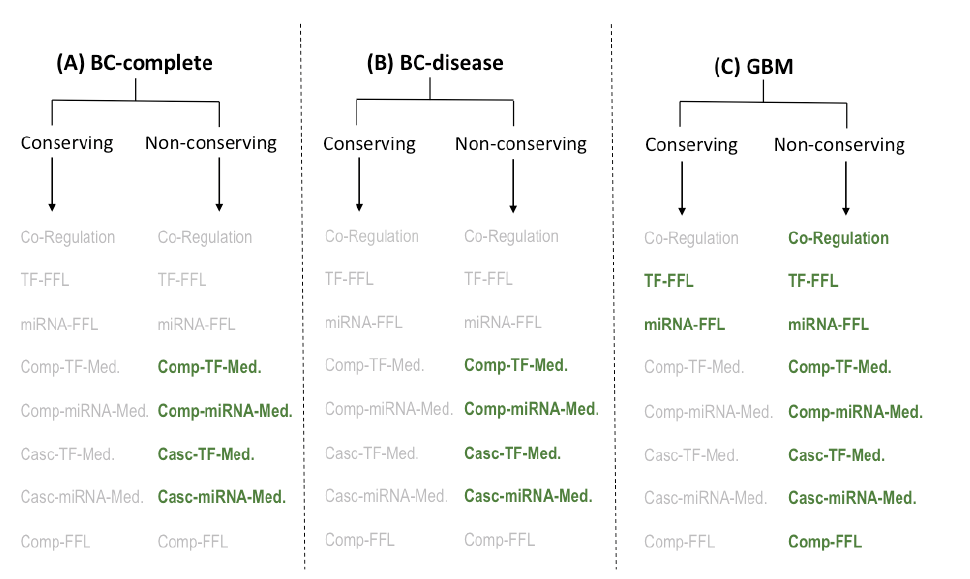
Figure 2: Significant 3-node motifs (highlighted in green) detected by the FANMOD tool with two different randomiza- tion